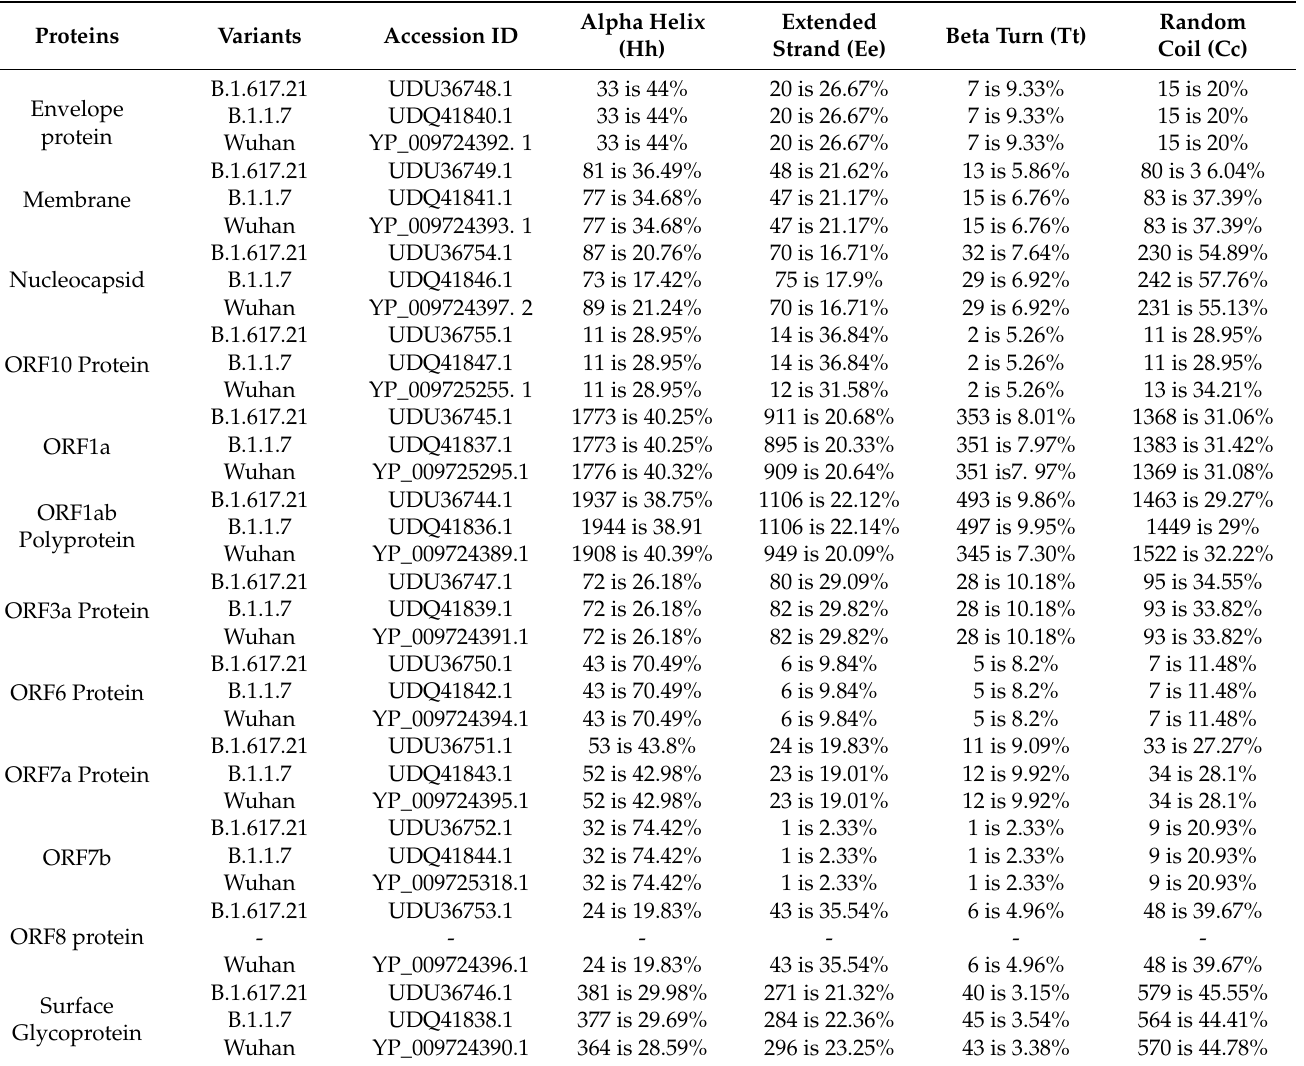
Table 1. Comparison of the secondary structures of the proteins of SARS-CoV strains B.1.617.21 and B.1.1.7 with a reference strain of